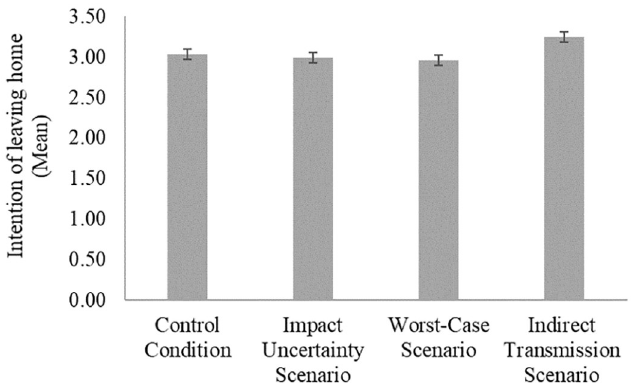
Fig 2. The intention of leaving home for the four scenarios presented. Error bars represent the standard error of the mean.